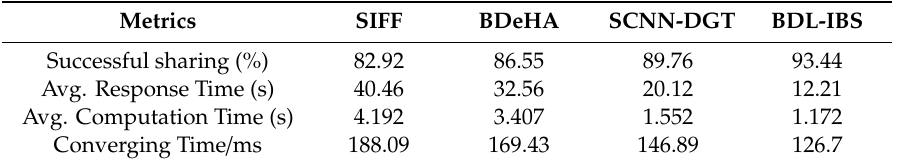
Figure 7. Converging time versus malicious impact factor. Table 5. Comparative Analysis.